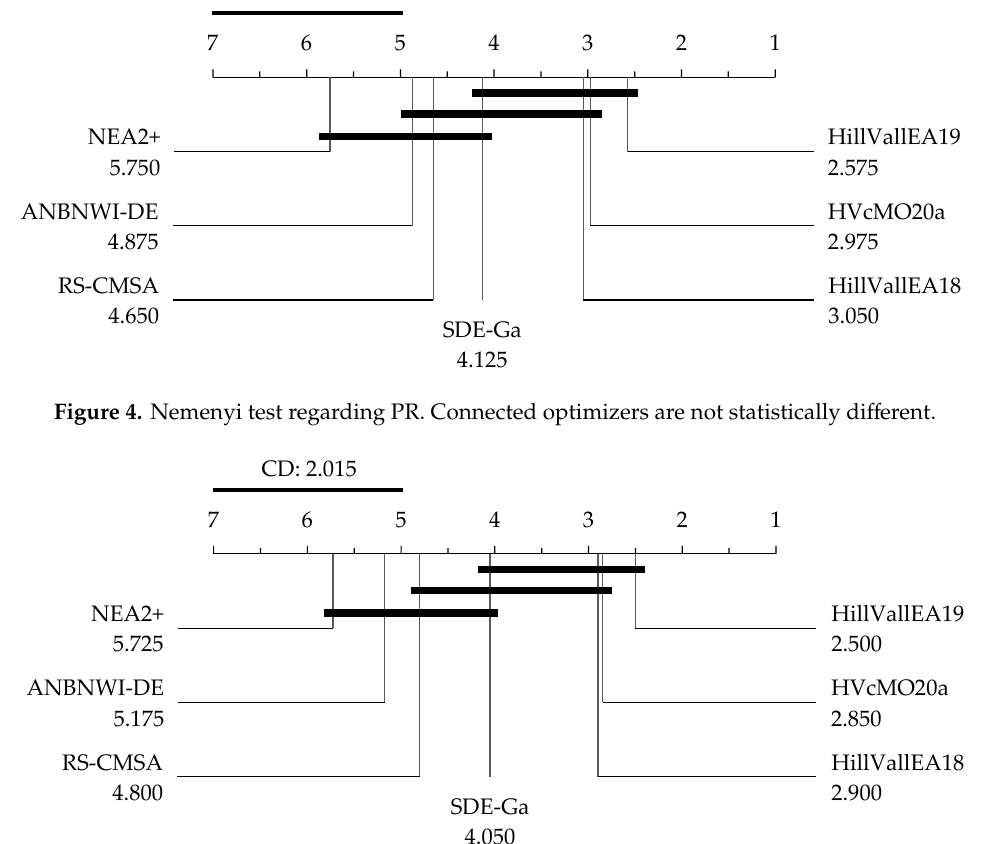
Figure 5. Nemenyi test regarding F1. Connected optimizers are not statistically different.